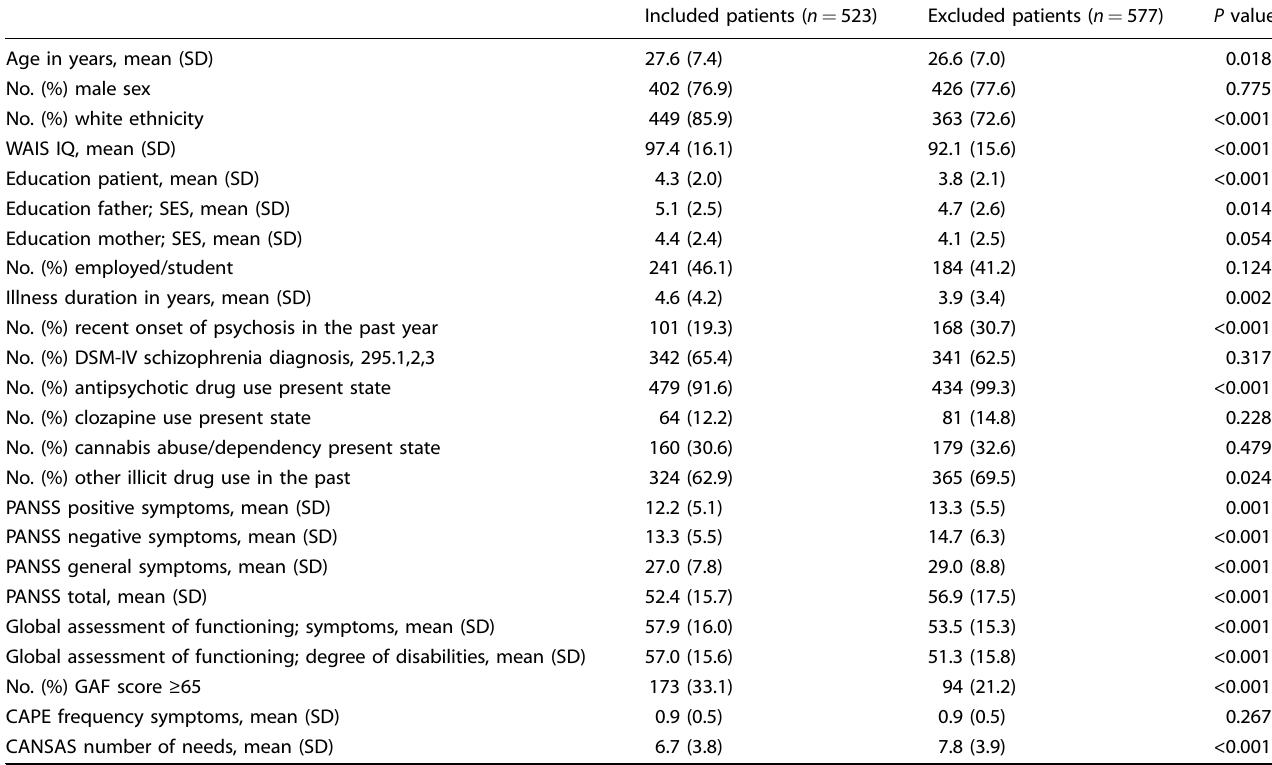
Table 1. Baseline demographic and clinical characteristics of patients who completed baseline and follow-ups and of those who were not included in the